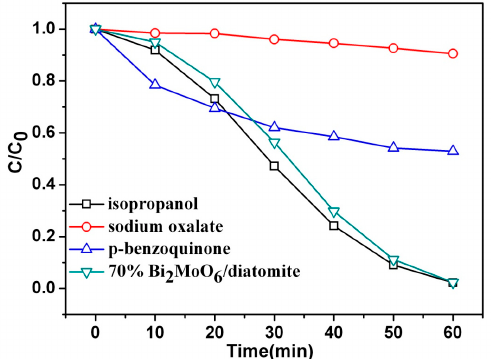
Figure 9. Effect of different kinds of trapping agents on the degradation of RhB solution by visible light irradiation.